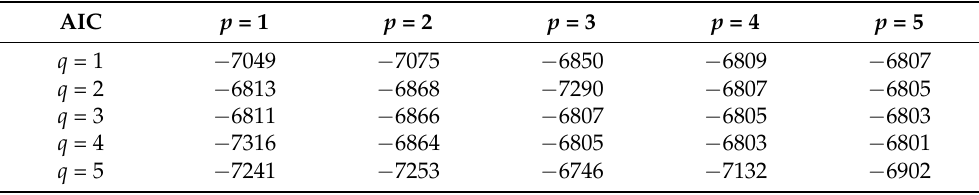
Table 3. Results of ADC.